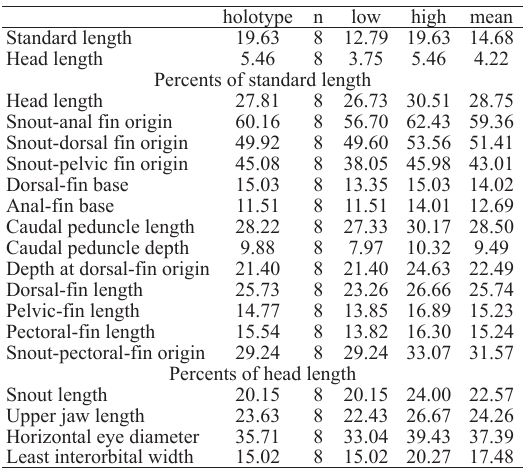
Table 1. Measurements of Amazonspinther dalmata, new species, holotype and